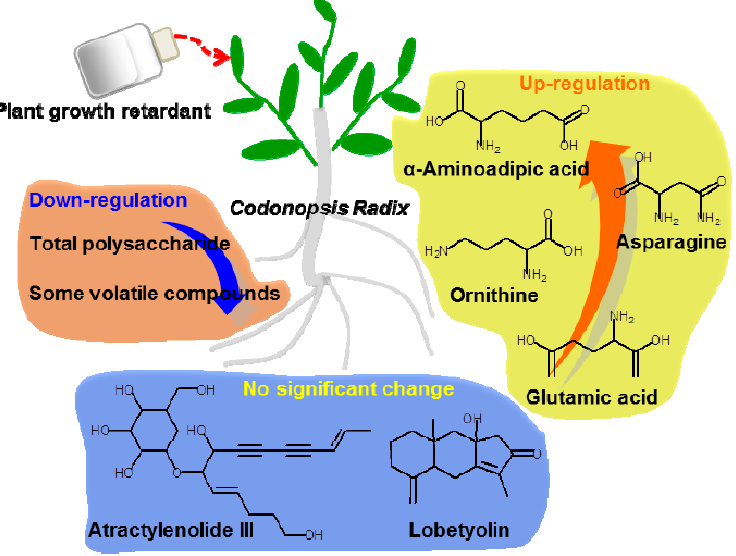
Figure 4. Summary on effect of PGR on C. Radix samples.